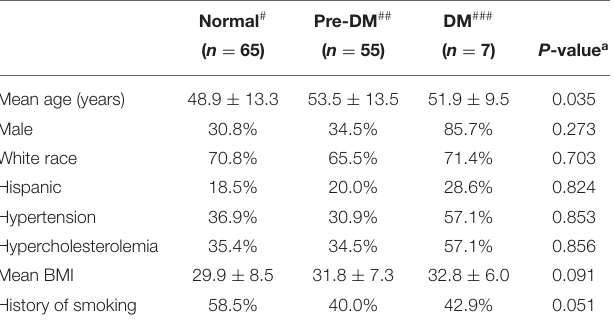
TABLE 2 | Outcomes of POC HbA1c screening summarized by participant